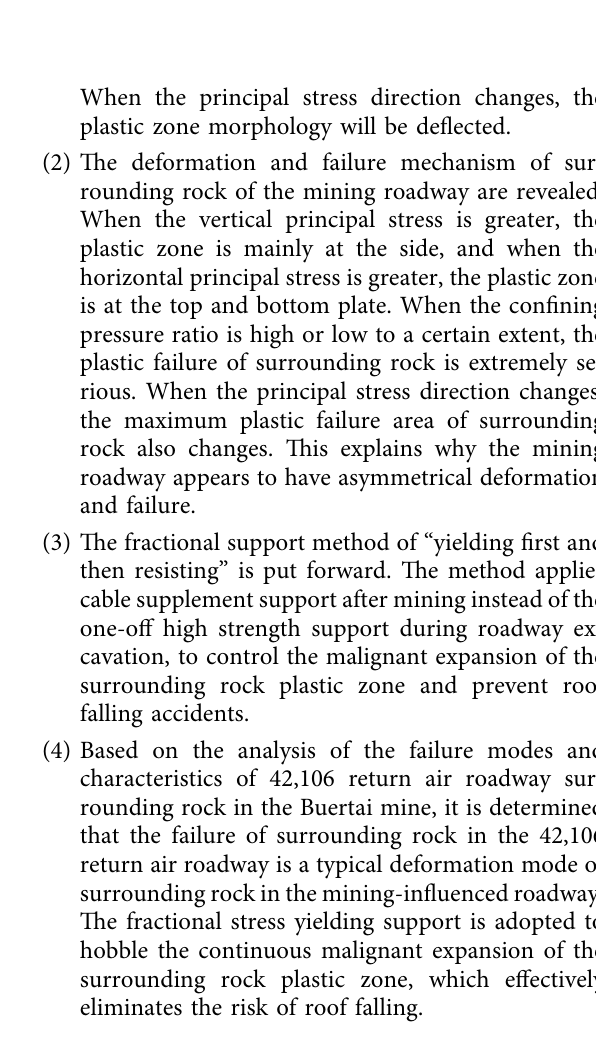
Figure 10: Support of the 42,106 return air roadway. (a) Roadway section diagram. (b) Plane diagram of the roof. (c) Positive sidewall section diagram. (d) Plane diagram of the negative